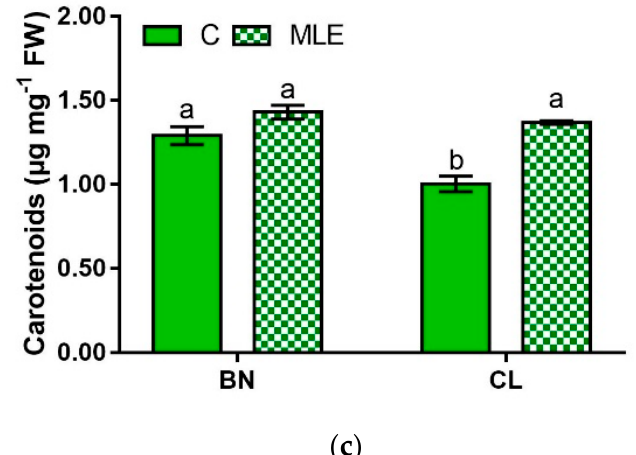
Figure 3. Effect of interaction ( G × T ) of chlorophyll a ( a ), chlorophyll b ( b ) and total carotenoid content ( c ), from leaves of BN and CL treated with distilled water (C) and MLE. Values are the means ± S.E ( n = 3). Different letters indicate the differences among treatments.